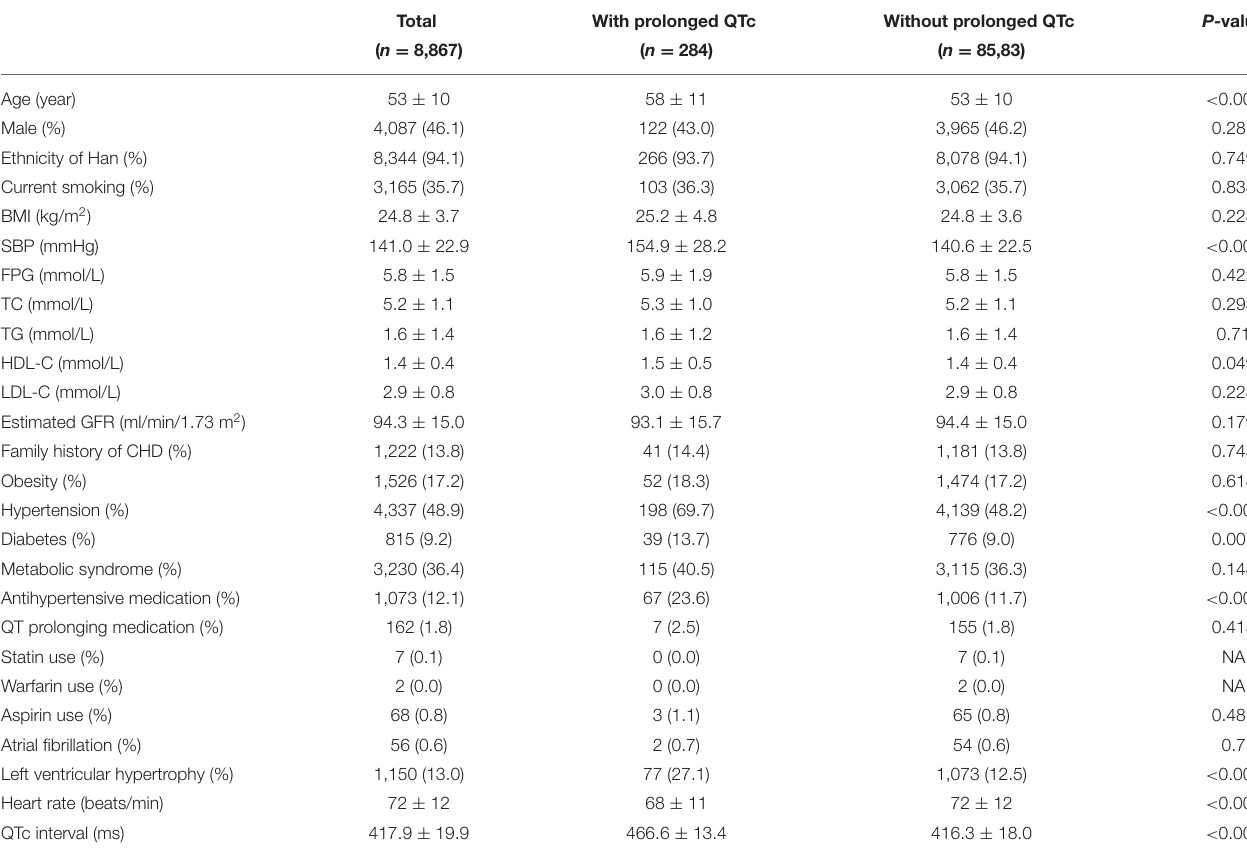
TABLE 1 | Baseline characteristics of the included participants by prolonged QTc interval.